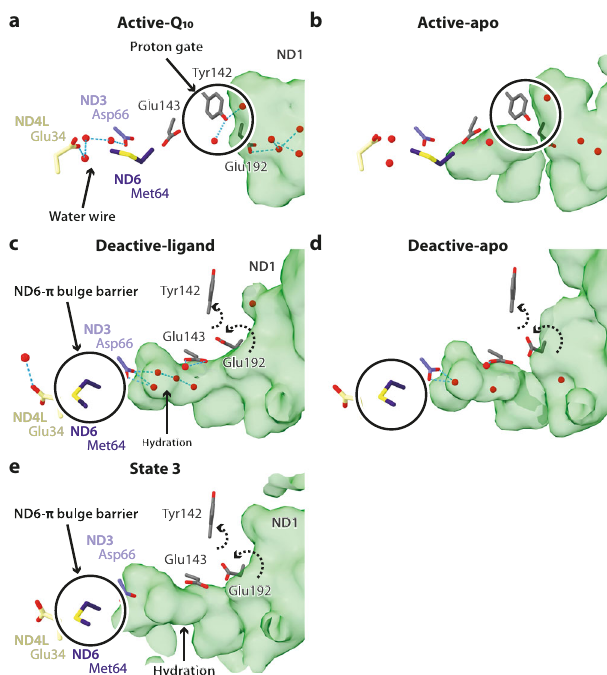
Fig. 6 The ND1 cavity and the E-channel that connect the Q-site to the fi rst antiporter-like subunit ND2. The proton pathways from subunits ND1 to ND4L in the ( a ) active-Q 10 , ( b ) active-apo, ( c ) deactive-ligand, ( d ) deactive-apo, and ( e ) state 3 states. Cavities (green surfaces) were identi fi ed by CASTp 45 using a 1.4 Å probe. E-channel residues are shown in sticks and labelled. Dashed arrows indicate movement of residues with respect to their conformations in the active